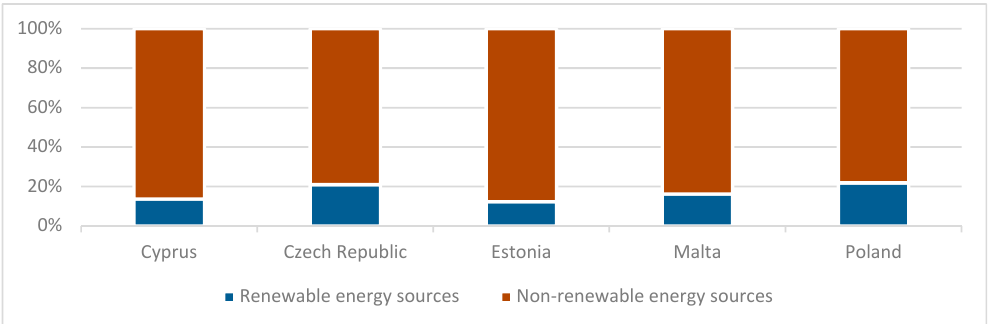
Figure 10. Energy sources in the countries of group A in 2016.